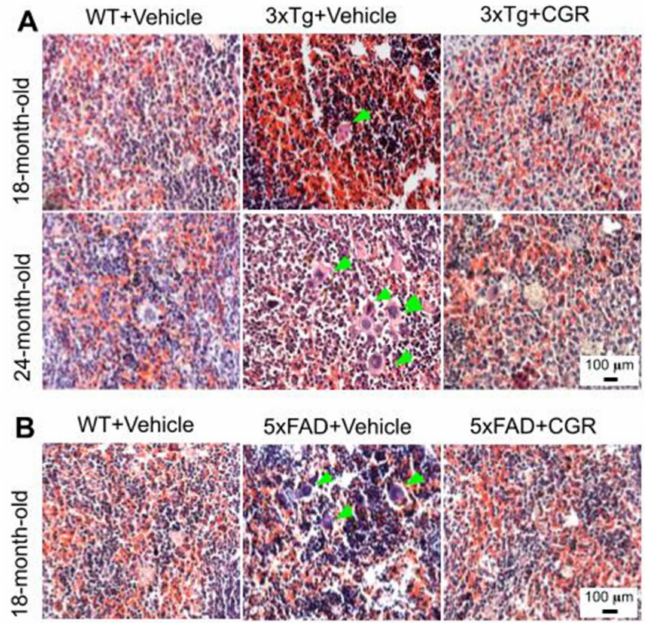
Figure 4. Splenic red-pulp cytoarchitecture was improved by CGR treatment in white-pulp of 5xFAD mice and red pulp of both 3xTg and 5xFAD mice. Wild-type, 3xTg, 5xFAD mice treated with CGR (100 mg/kg) for 2 months and the mice were perfused with PBS and fixed with 4% paraformaldehyde and the spleen was dissected out, embedded with paraffin and 5 µ m thick section was cut and stained with hematoxylin and eosin stain and the images were taken by compound light microscope using either 10 × or 40 × objectives (total magnification = 100 × or 400 × ). A: Representative images of splenic red pulp from 18- and 24-month-old 3xTg mice ( A ) and 18 months-old 5xFAD mice ( B ) after treatment with CGR. A significant degeneration of red-pulp, along with increased phagocytic cells (green arrows) in both these mice groups were observed, whereas CGR ameliorated these changes. Scale bar = 100 µ m and is applicable to all other images.